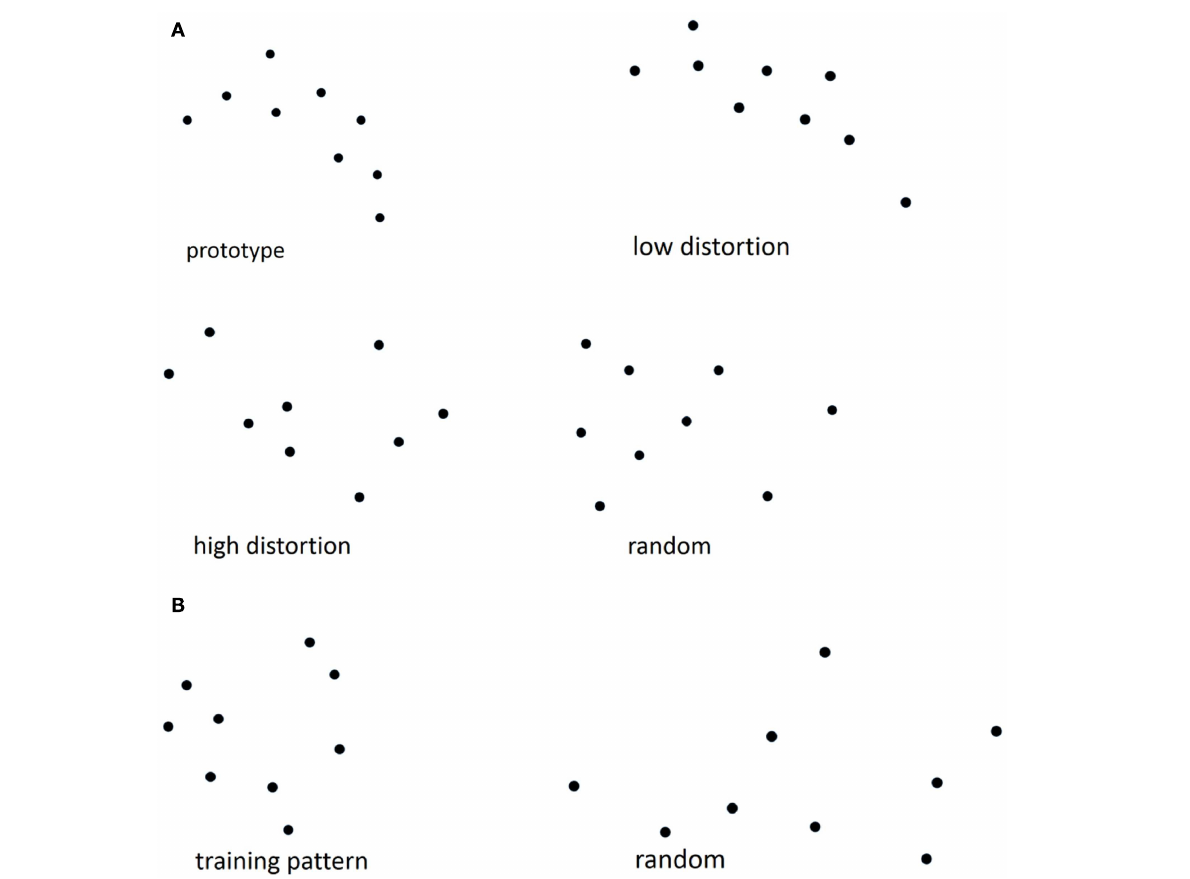
ratio from the CVLT and letter (F-A-S) and category